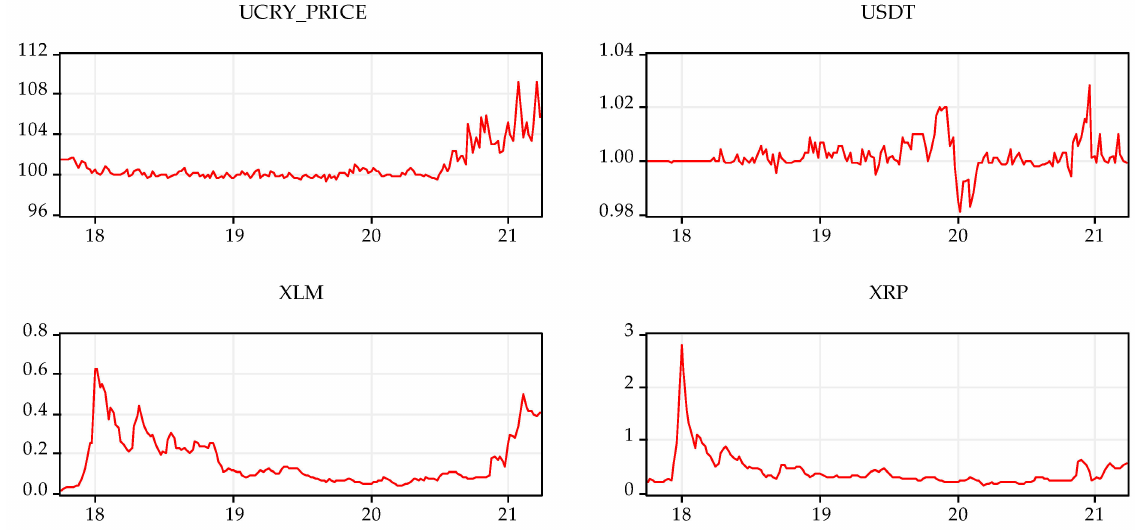
Figure A1. Plots for level